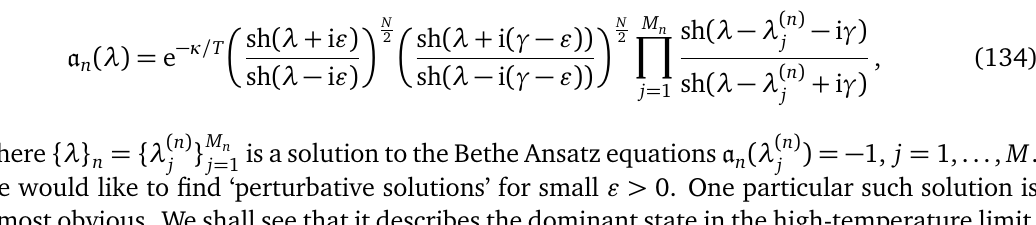
on the real line at j